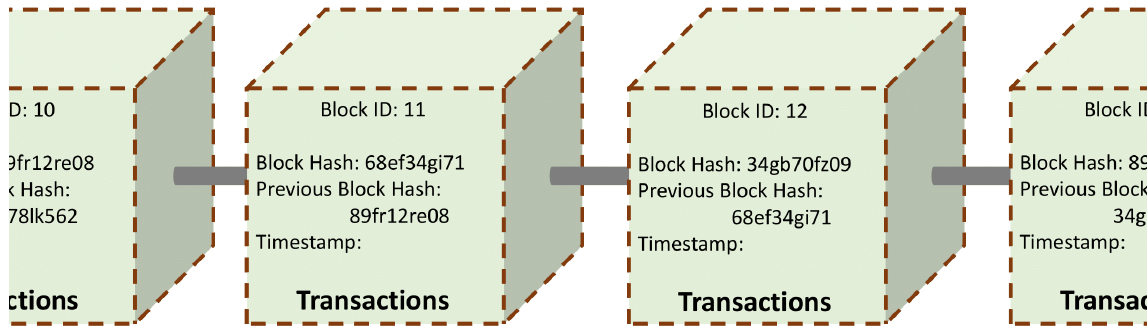
Figure 3. An overview of Blockchain technology.